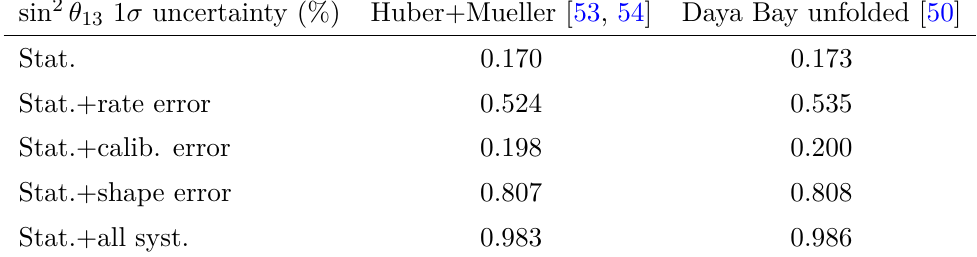
Table 3 . The sin 2 θ 13 1 σ precision sensitivity under different consideration of the uncertainties with the Huber-Mueller flux model and the Daya Bay unfolded flux model. The latter naturally includes the reactor antineutrino anomaly and the “5 MeV excess”. The 6% deficit reduces the statistics and the “5 MeV excess” slightly benefits the sin 2 θ 13 precision measurement. All results are for the detector installed at 2.0 km from the reactor and 150 kton · GW · year luminosity. slightly improve the sensitivity as shown in table 3. The Double Chooz experiment